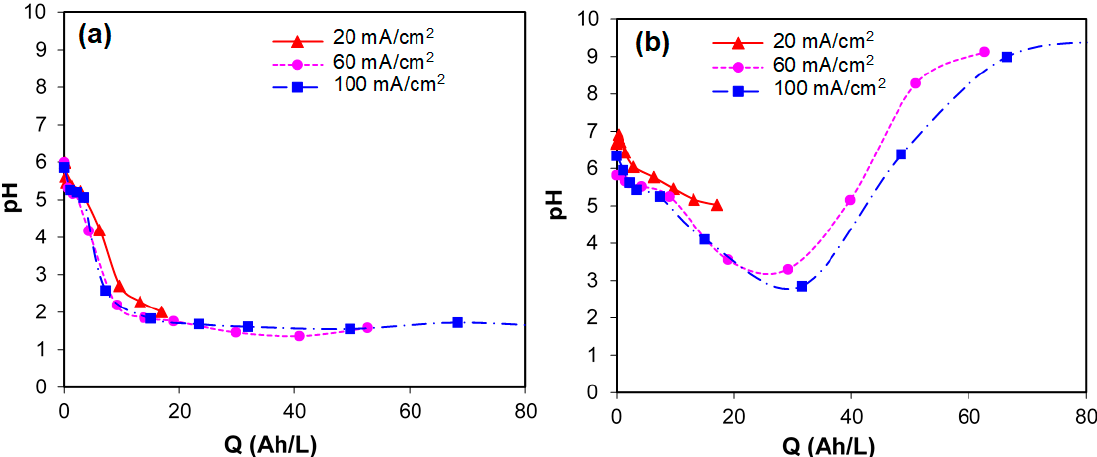
Figure 5. Changes of pH with the specific electric charge during electrolytic treatment of synthetic urine at pH 5.5 and at room temperature (25 °C) using BDD (a) and DSA (b) anodes and a stainless steel cathode with a flow rate of 800 mL/min at different values of applied current densities: ( ▲ ) 20 mA/cm 2 , ( ● ) 60 mA/cm 2 , and ( ■ ) 100 mA/cm 2 .